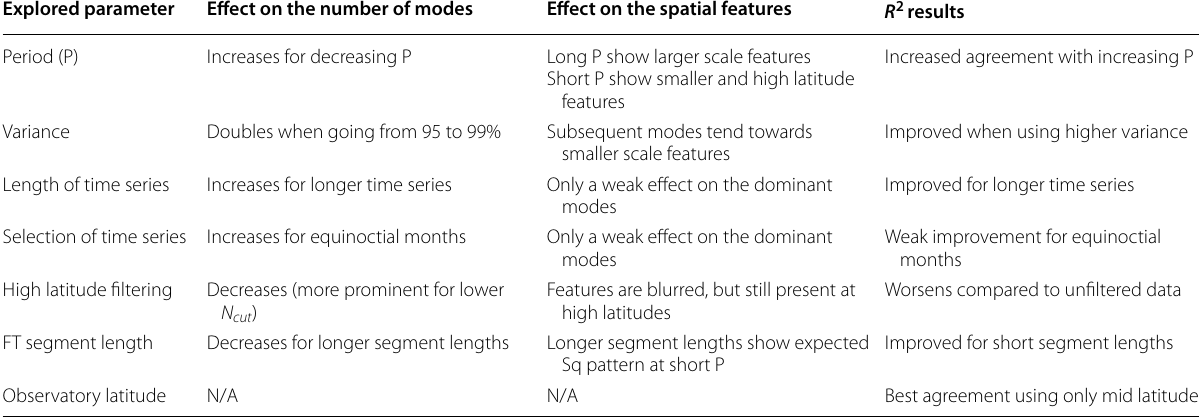
Table 2 Table listing the major findings of this work. The explored parameters are period P or 99% provided by PCA; total length of time series used for PCA (maximum—almost 1 year, minimum—2 weeks); selection of time series (separating them into sections); high latitude filtering by applying an SH filter of degree N cut ; segment length along which a Fourier transform is applied (24, 48, 72 h); and latitude of observatory stations used for the estimation of the source coefficient. “N/A” stands for not